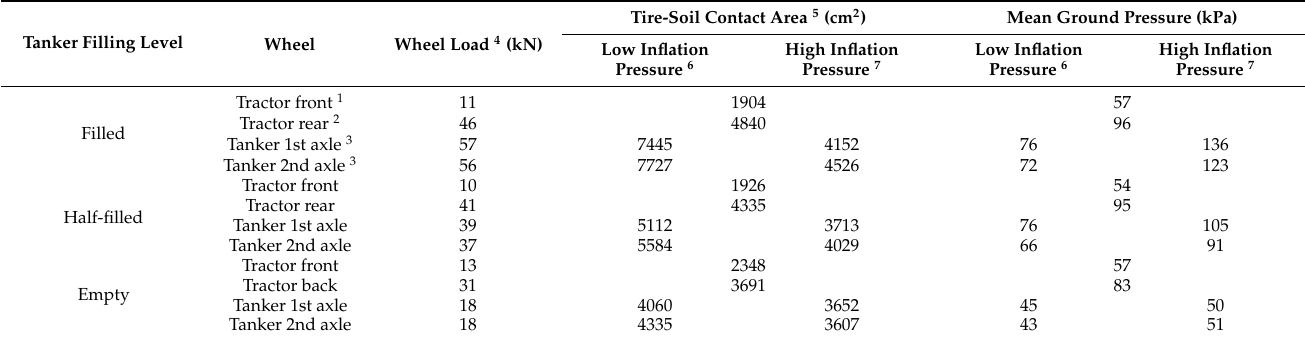
Table 1. Characteristics of the experimental design with technical parameters.